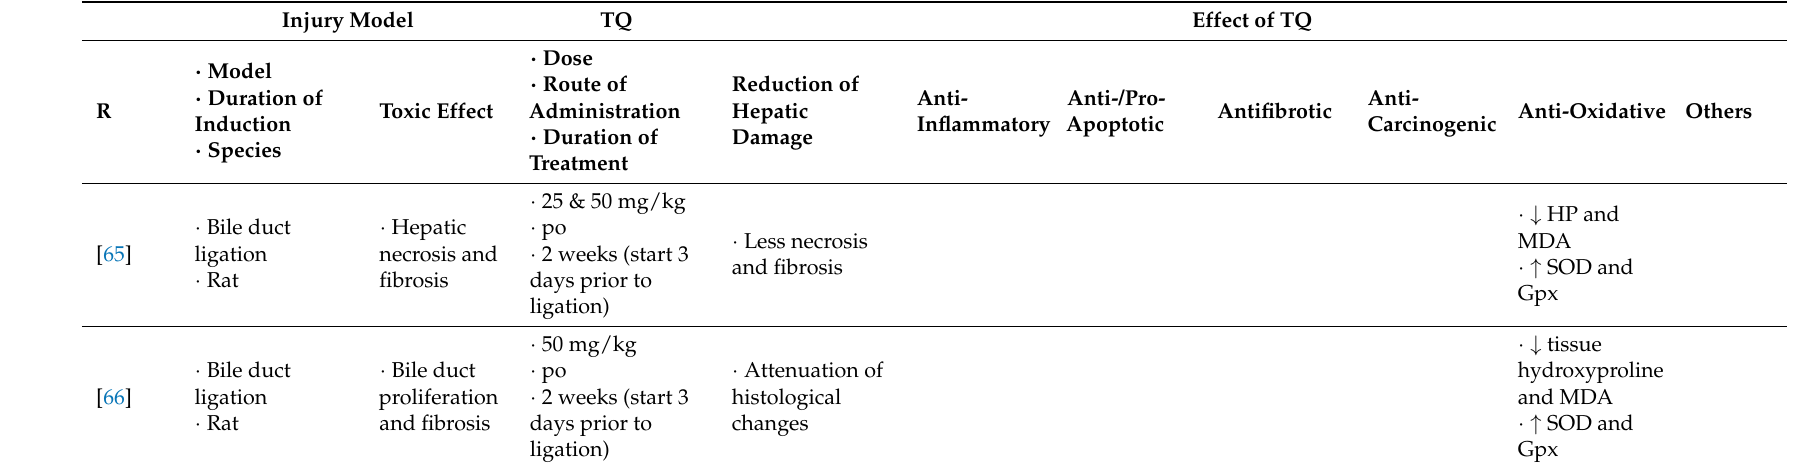
Table 7. Effects on liver injury caused by